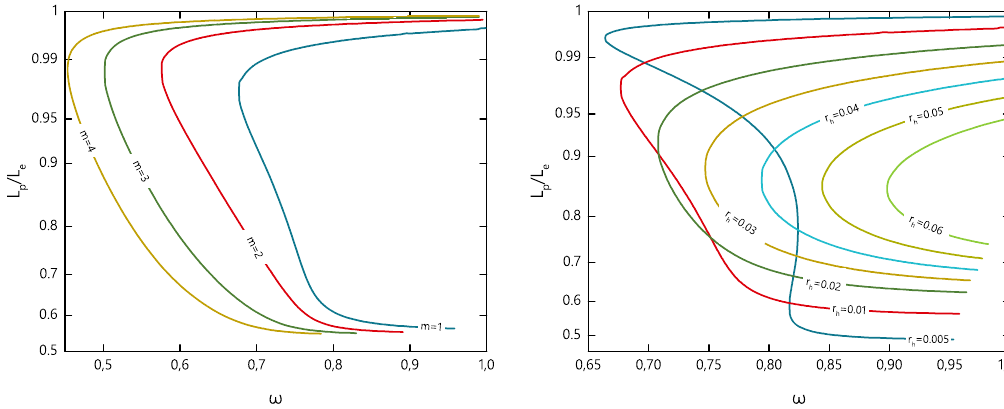
Figure 7 . The ratio of the horizon circumferences L e =L p is shown as a function of: winding number m (left panel), for (cid:12)xed r h = 0 : 01; angular frequency ! (right panel) for the forward branch solutions with m = 1. Here all solutions have (cid:11) = 0 :